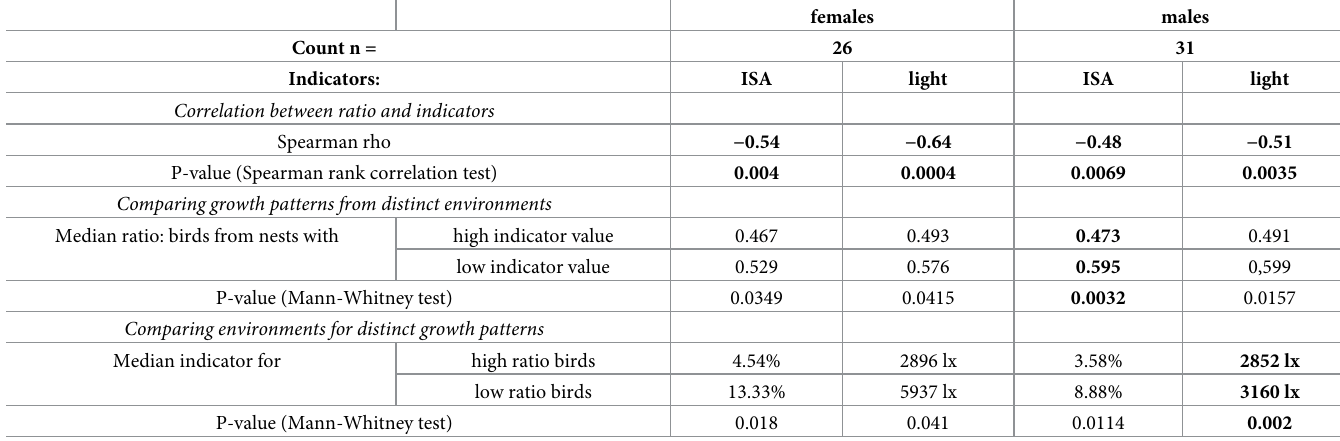
Table 2. Tests for significant associations between the ratios for blue tits and the indicators impervious area (ISA) and light pollution.